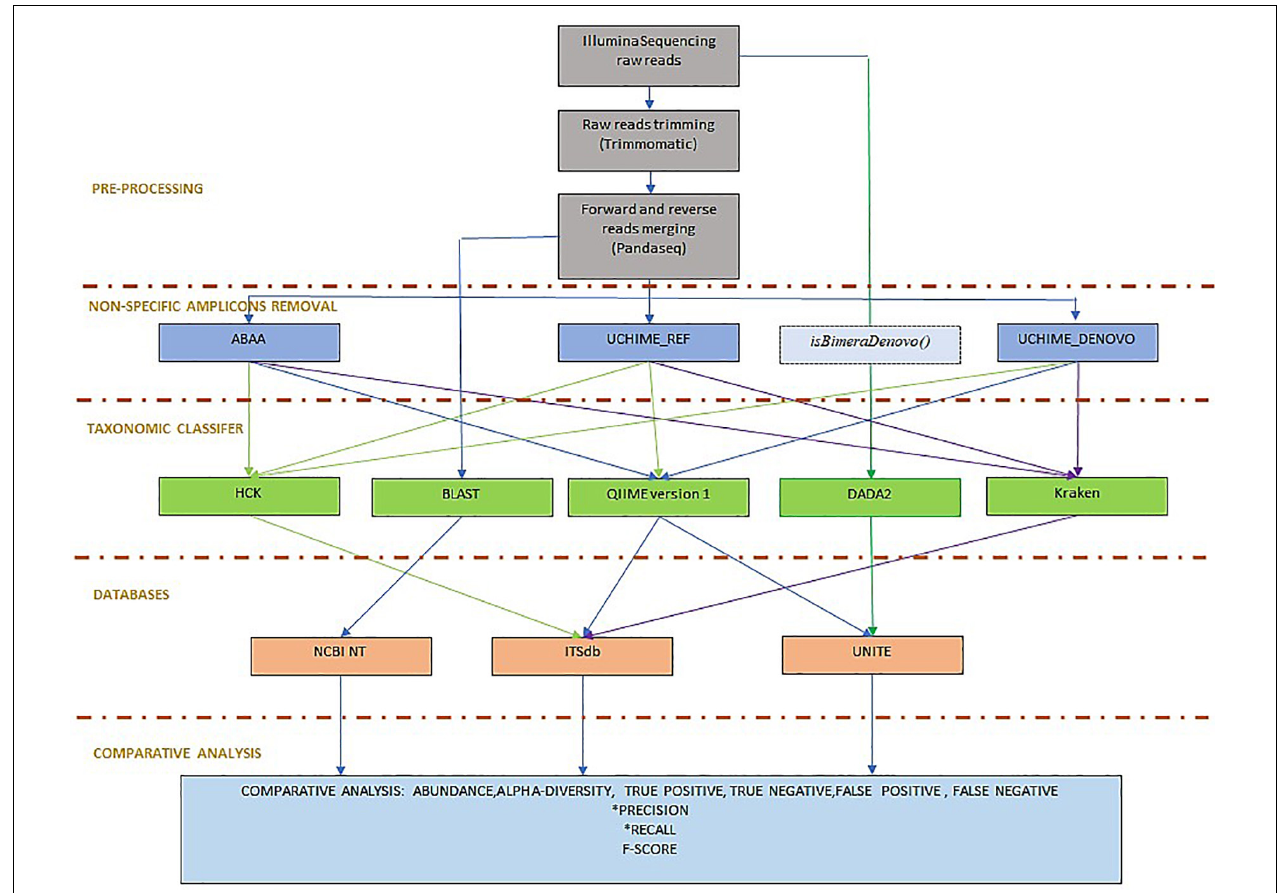
FIGURE 2 | Benchmarking workflow: the workflow is organised in pre-processing, including Illumina sequencing reads trimming and forward and reverse reads merging. To determine the best non-specific amplicons filtering method, ABAA was tested with UCHIME (UCHIME_Ref, UCHIME_DENOVO, and isBimeraDenovo() implemented in DADA2. The classifier tested also includes HCK with ITSdb, the newly designed pipeline, QIIME with ITSdb and UNITE, Kraken with ITSdb, DADA2 with UNITE and compared to BLASTn search using NCBI NT database, as reference. The pipelines performances are evaluated using precision, recall and F-score.